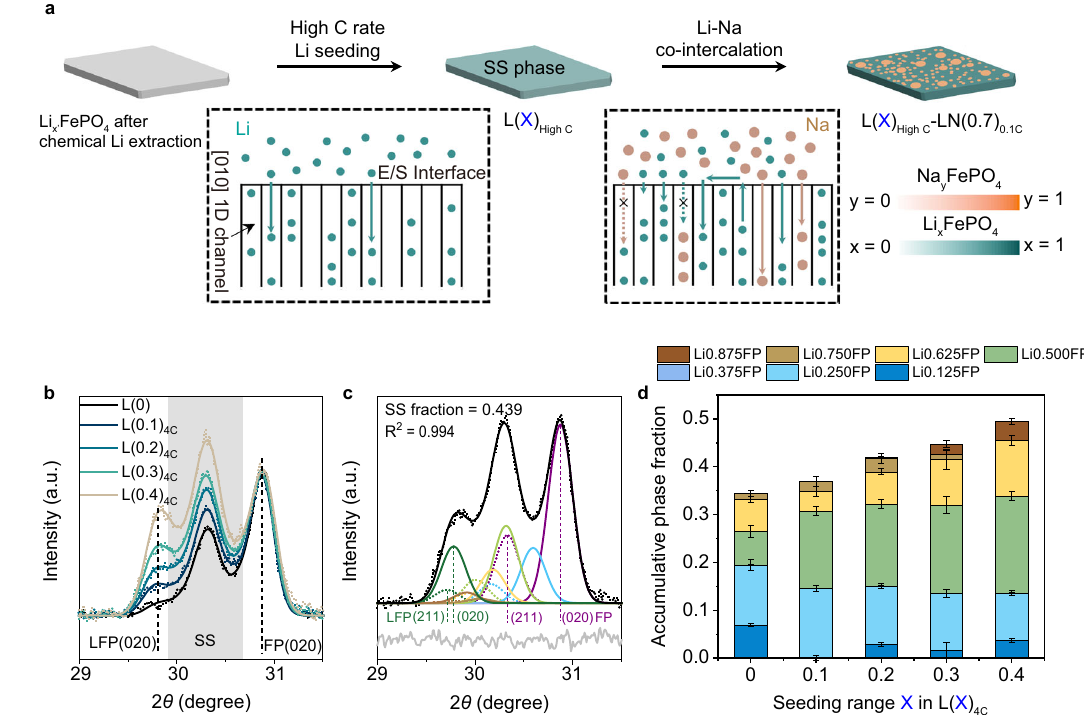
Fig. 2 | Seeding and quanti fi cation ofLi SS phases.a Schematic of the Liseeding and Li/Na ions co-intercalation processeshappening athighseeding C rates (>1C). Theinsetillustratesthepossibleintercalationpathwaysattheelectrode-electrolyte solution (E/S) interface. The initial host was prepared by chemical extraction. x ’ denotes the remnant quantity of Li in the structure. See “ Pre-seeding Li and quanti fi cation of SS phase fractions ” in the main text for more information. b NormalizedXRD(dottedline:rawdata;solidline: fi t)patternsofFePO 4 electrodes before(L(0))andafterseedingwithdifferentamountsofLi(10%,20%,30%and40% of the 147mAh/g total capacity) under 4C (588mA/g), labeled as L(0.1/0.2/0.3/ 0.4) 4C .Thenormalizationisbasedontheintensityof(020)peakforFePO 4 at30.9°.